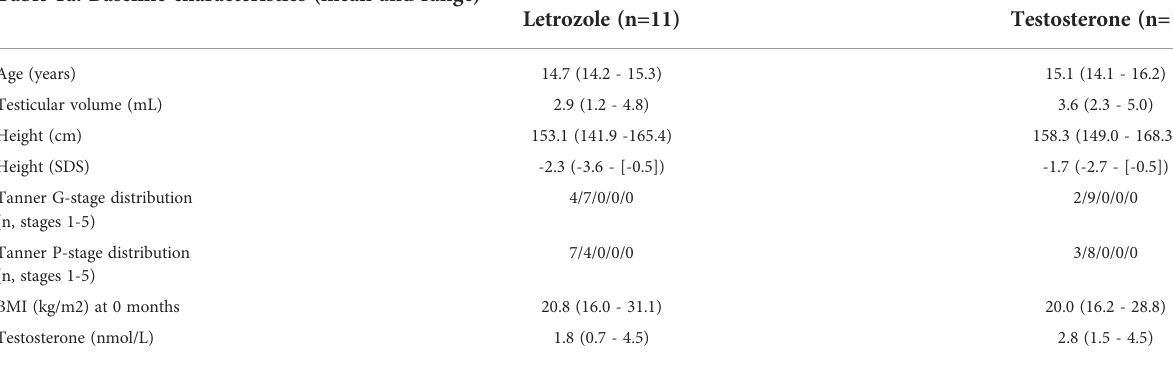
TABLE 1 Characteristics of the study population at baseline (a) and at 12 months (b), i.e. , six months after cessation of treatments. Table 1a: Baseline characteristics (mean and range)